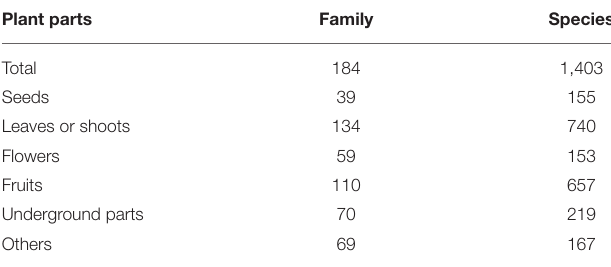
TABLE 2 | Taxonomic diversity of the edible species, total and